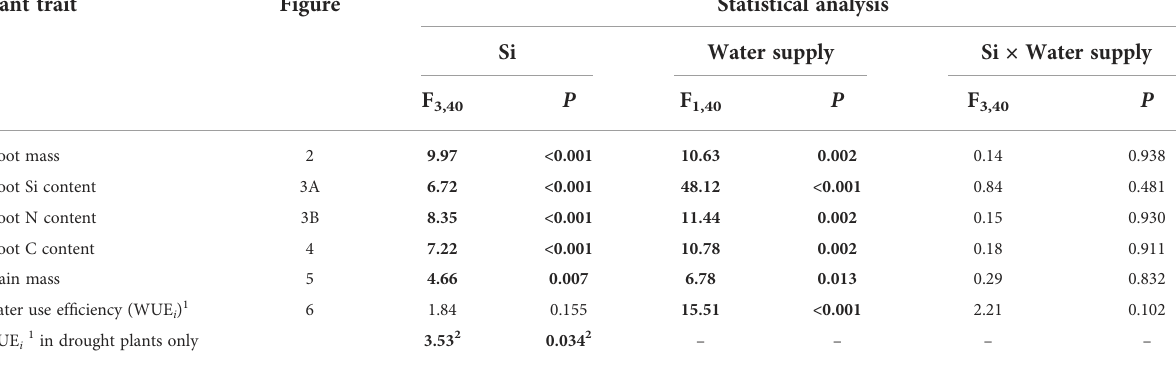
TABLE 1 Results of ANOVA analysis of plant trait responses to Si supplementation and water supply, and their interactive in fl uence on these responses. Plant trait Figure Statistical analysis